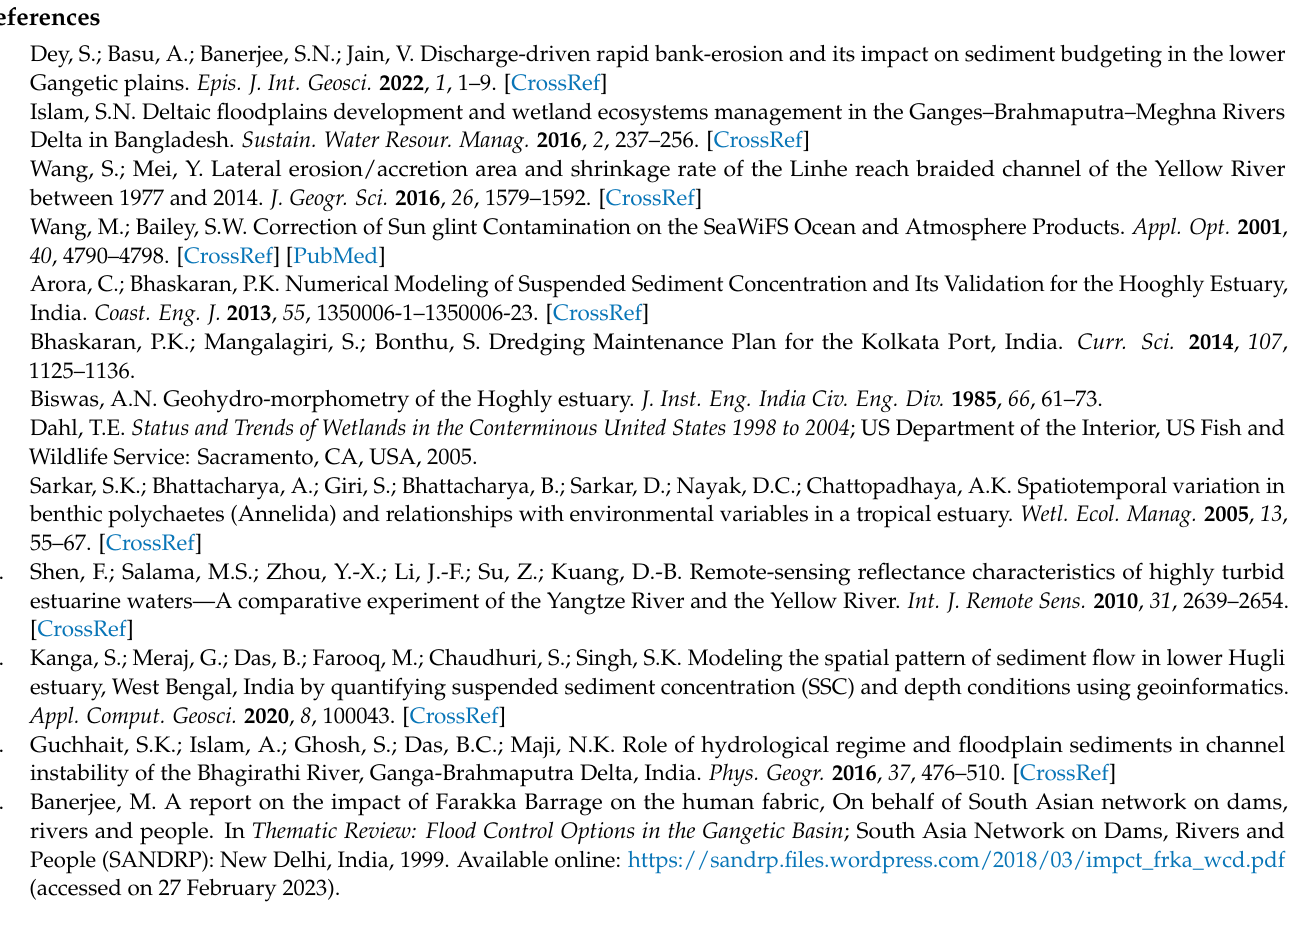
Figure A2. Regression analysis of the secondary in-situ SSC data and estimated R rs from Landsat data.